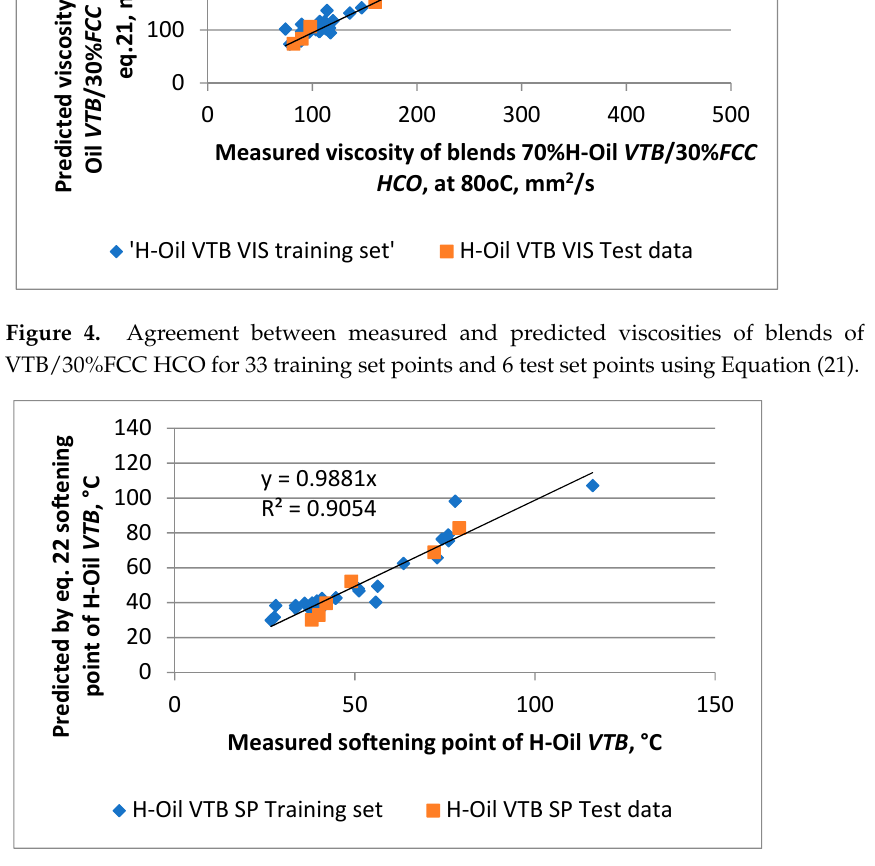
Figure 5. Agreement between measured and predicted softening points of the H-Oil VTB for 33 training set points and 6 test set points using Equation (22).